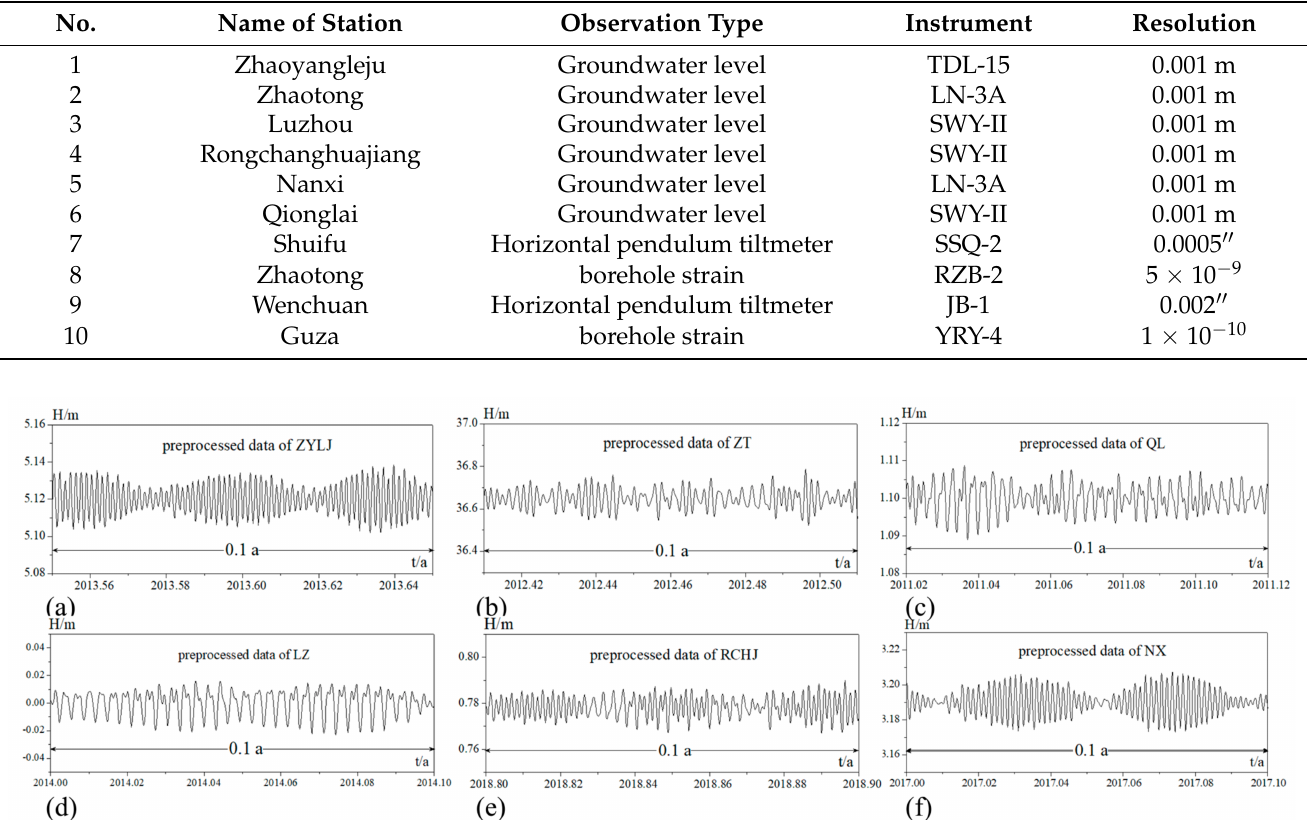
Figure 5. Raw data of groundwater level used for LURR calculation. The time of corresponding earthquakes in each of the maps is indicated by gray vertical arrows. The water level decrease in ( c ) after 12 May 2008 is induced by the Ms = 8.0 Wenchuan earthquake, while the rise in August 2010 is caused by the man-made transformation. The slow drop from 2014 to 2016 in ( f ) result from the artificial effect of pumping in a nearby well of a winery, and the sudden drops on 29 August 2017 and 16 December 2018 are derived from the artificial adjustment and the Ms = 5.7 Xingwen earthquake, respectively. There were no obvious interferences of precipitation, seismicity and artificial noise in ( a , b , d , e ). Table 2. The instruments and their resolution of the geophysical observations in Figure 4.